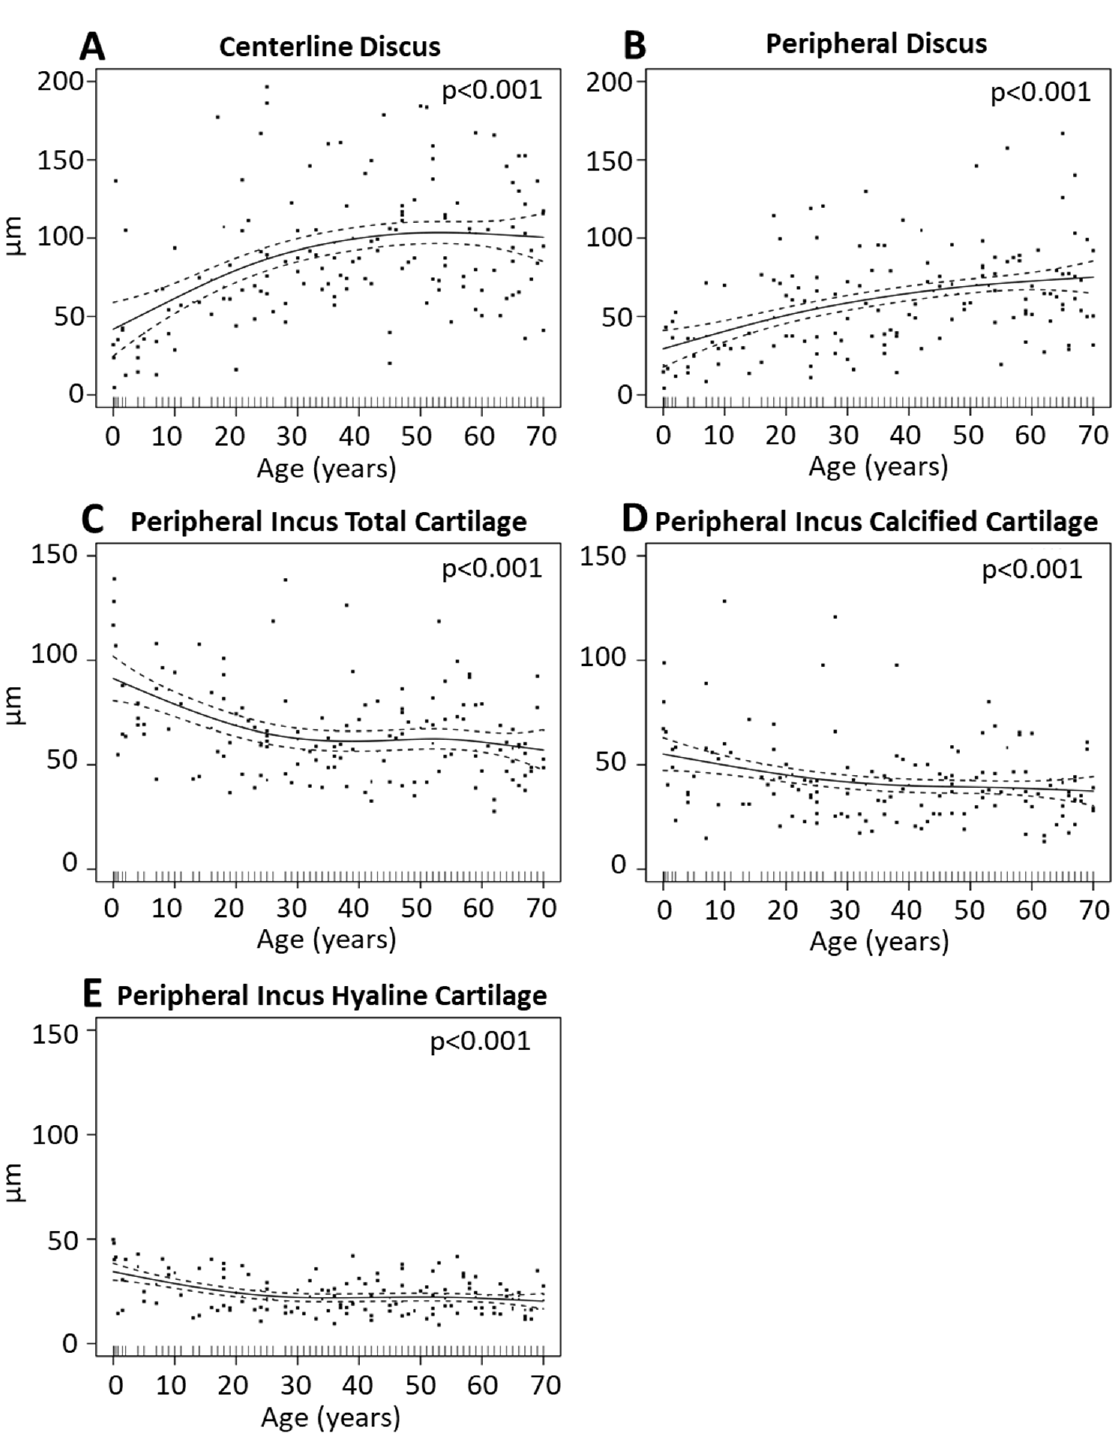
Figure 3. Incudo-mallear joint (IMJ) geometrical variation with age. Indicated are generalized cross-validation optimal non-parametric regression curves (solid) of the significant parameters: ( A ) Centerline Discus, ( B ) Peripheral Discus, ( C ) Peripheral Inc C tot, ( D ) Peripheral Inc cC, and ( E ) Peripheral Inc hC. The dotted lines form the 95% pointwise confidence intervals. The black dots represent single measurements. The black lines on the x-axis indicate the age of each individual.